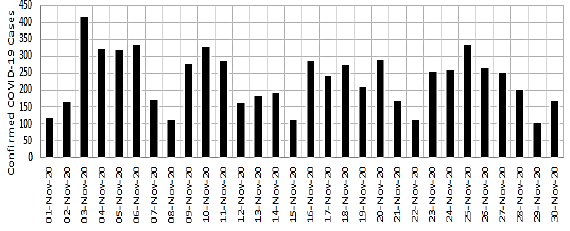
Figure 5. Daily cases in NCR from 11/01 to 11/30, 2020.